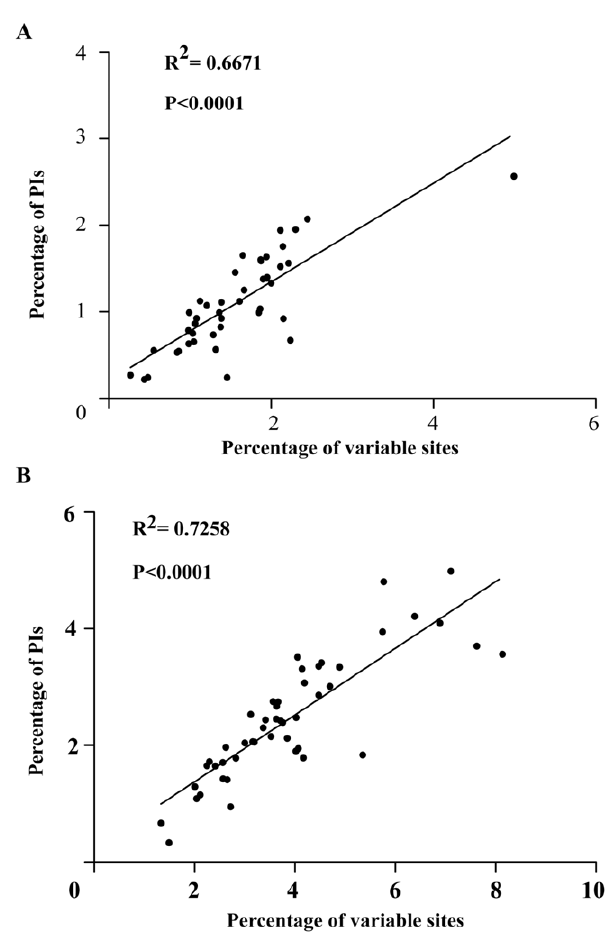
Figure 9. Linear relationship between percentages of parsimo- ny informative characters (PIs) and percentages of variable sites. A ) Coding region. B ) Noncoding region. The fitted slope from linear regression analysis is